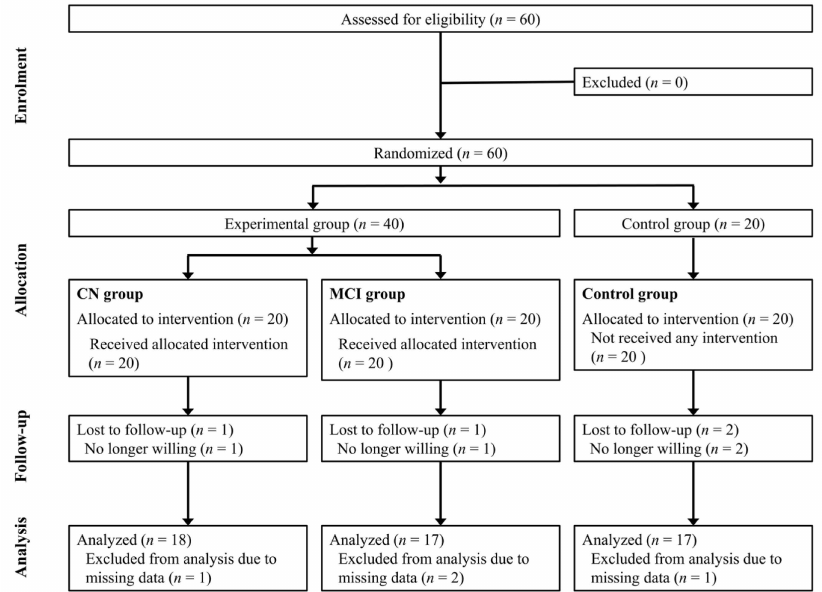
Figure 1. Consolidated Standards of Reporting Trials (CONSORT) diagram of participants in the randomized clinical trial. CN, cognitively normal; MCI, mild cognitive